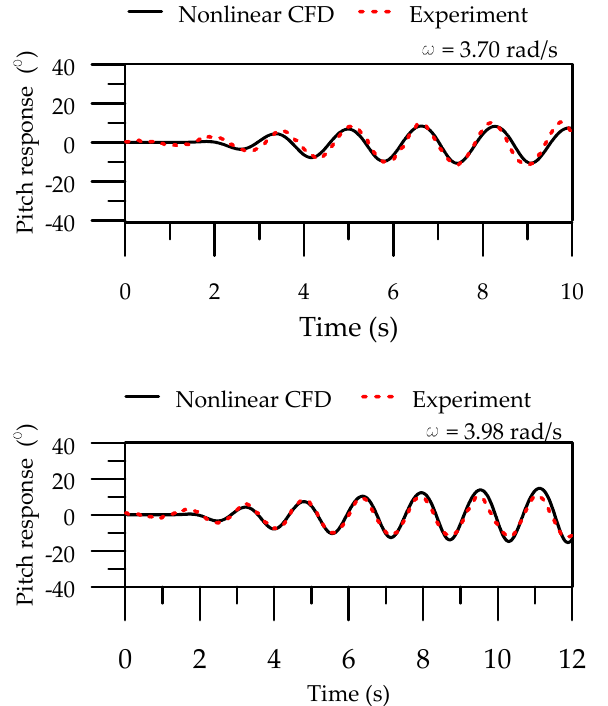
Figure 6. Comparison of nonlinear CFD and experimental results of pitch response for the isolated WEC rotor.